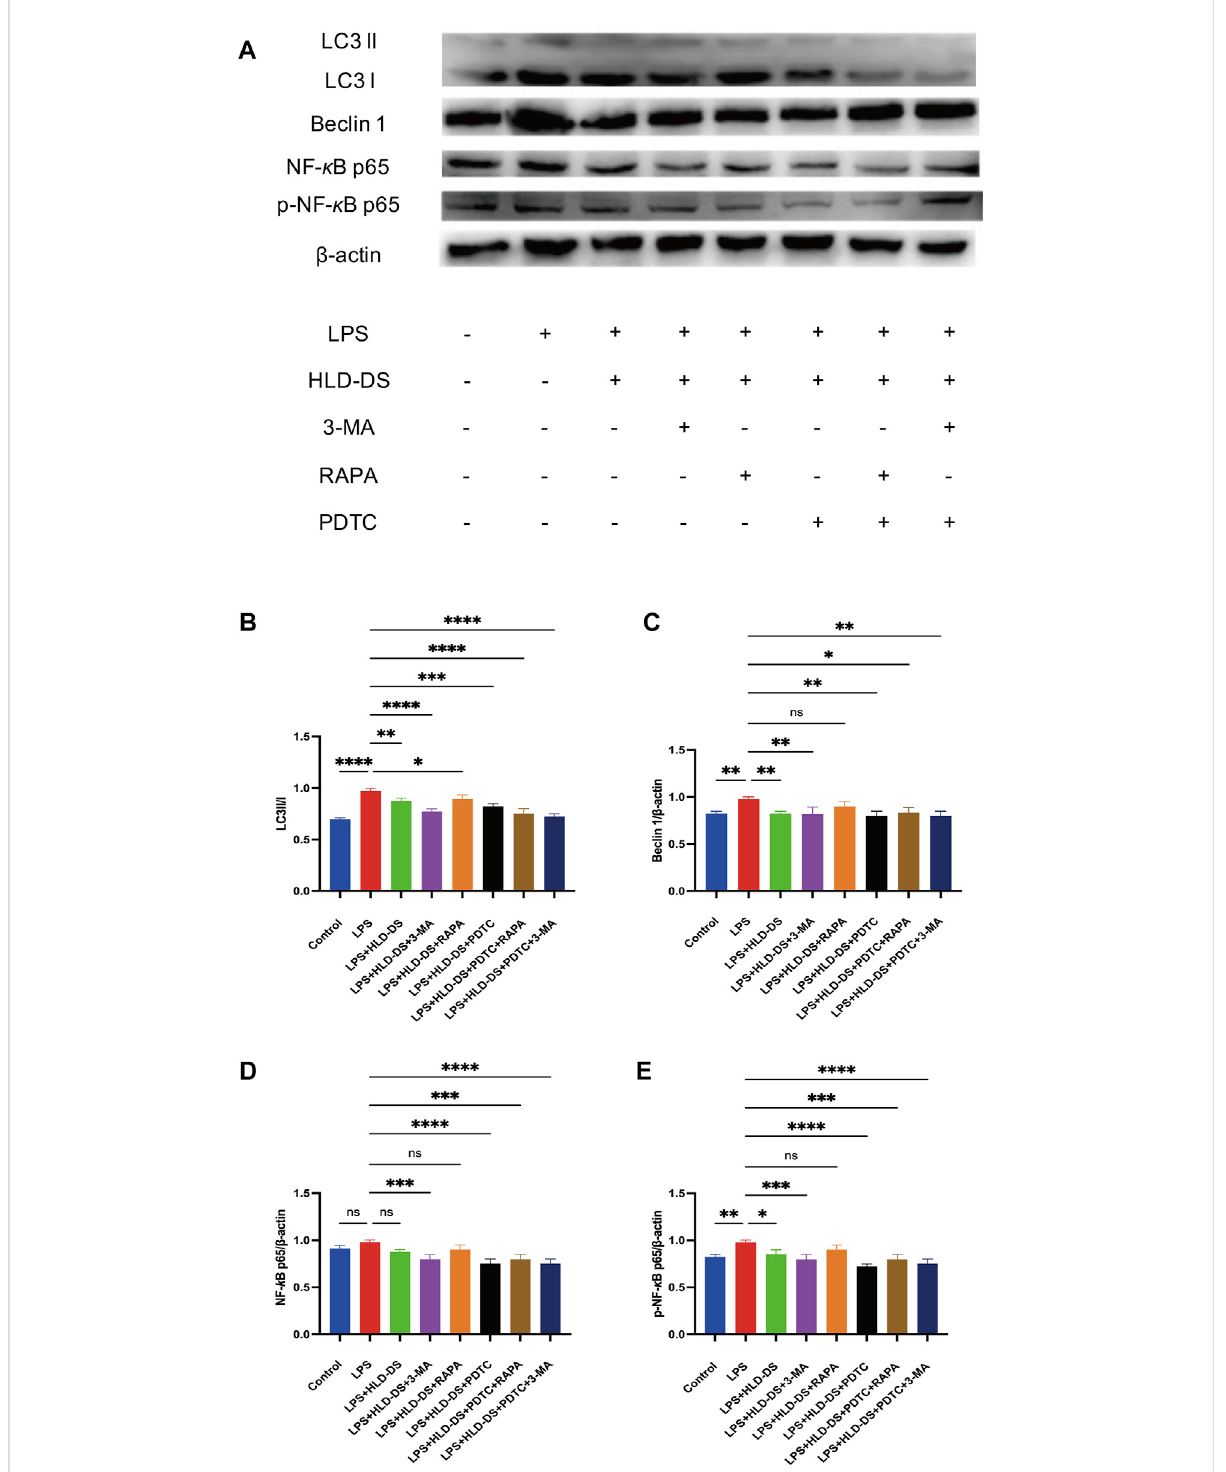
FIGURE 9 HLD-DS affected protein expressions related to the NF- κ B pathway and autophagy. (A) Western blots of LC3I, LC3II, Beclin 1, NF- κ B p65, and p-NF- κ B p65 in LPS-induced NCM-460 cells. (B) Quantitative results of LC3II/LC3I protein expression in LPS-induced NCM460 cells. (C) Quantitative results of Beclin I protein expression in LPS-induced NCM460 cells. (D , E) Quantitative results of NF- κ B p65 and p-NF- κ B p65 protein expression in LPS-induced NCM460 cells. All data are expressed as the mean ± SD. ( n = 3). * p < 0.05, ** p < 0.01, *** p < 0.001, **** p <